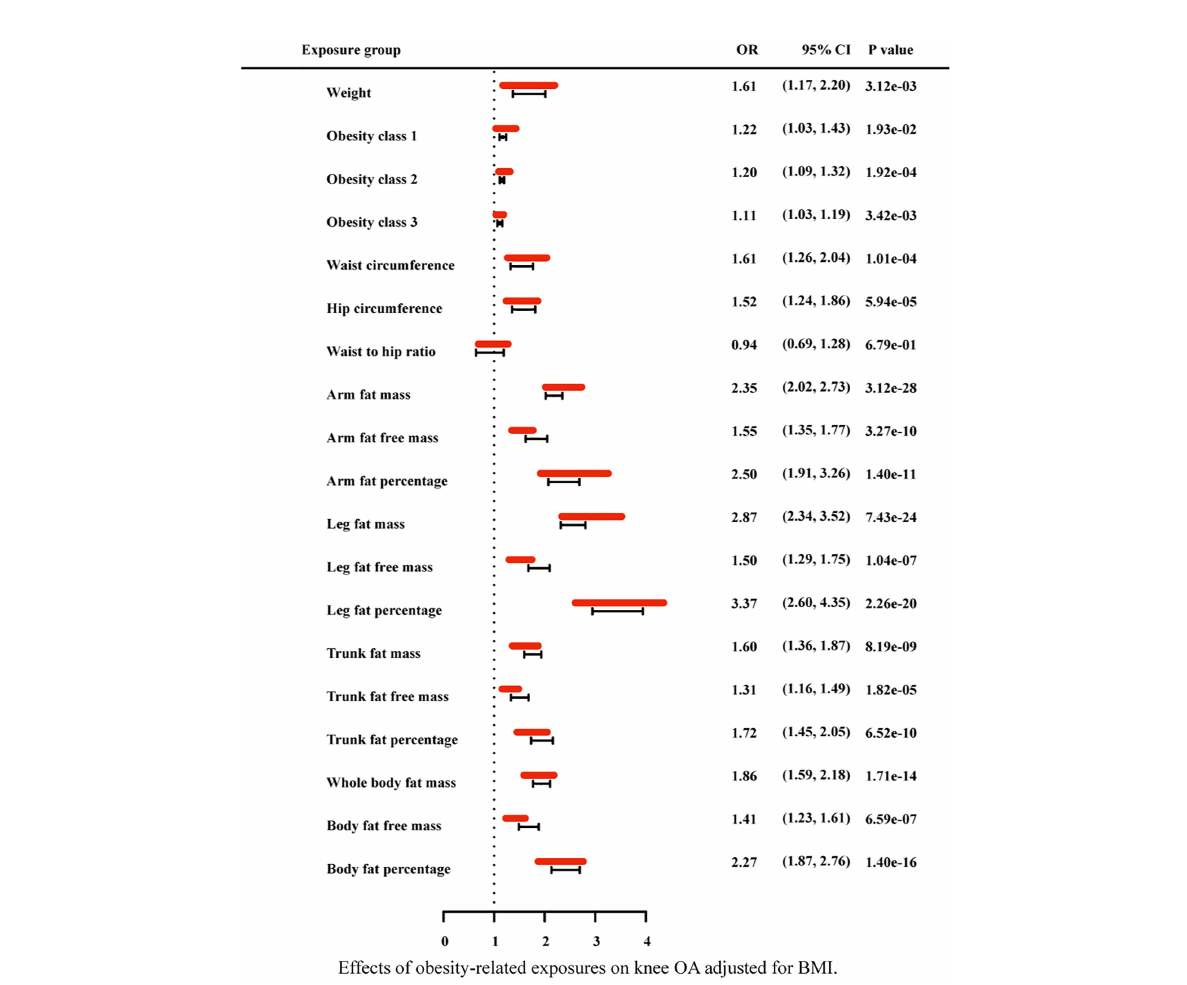
FIGURE 7 Effects of obesity-related exposures on knee OA adjusted for BMI. Results from multivariable MR analyses showing the effects of genetic predicted obesity related anthropometric indicators and body compositions on knee OA after adjusting for the effect of BMI, represented by red